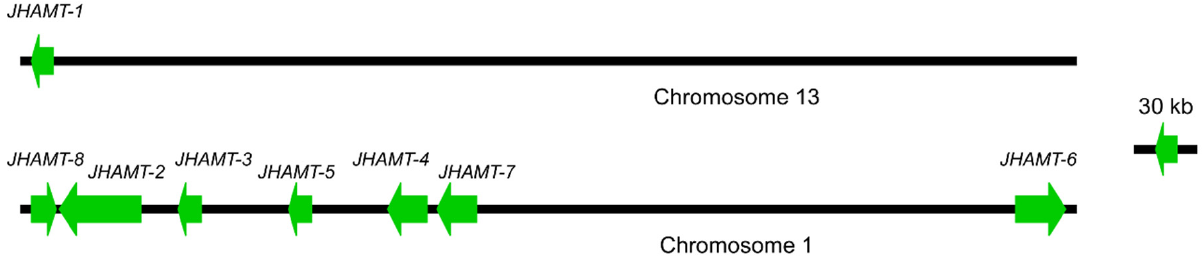
Figure 1. Chromosomal distribution of eight JHAMT genes in P. pseudoannulata . Only regions (black line) containing target genes were illustrated at the chromosomes. Green arrows represented genes and indicated the relative direction of genes to the chromosome.